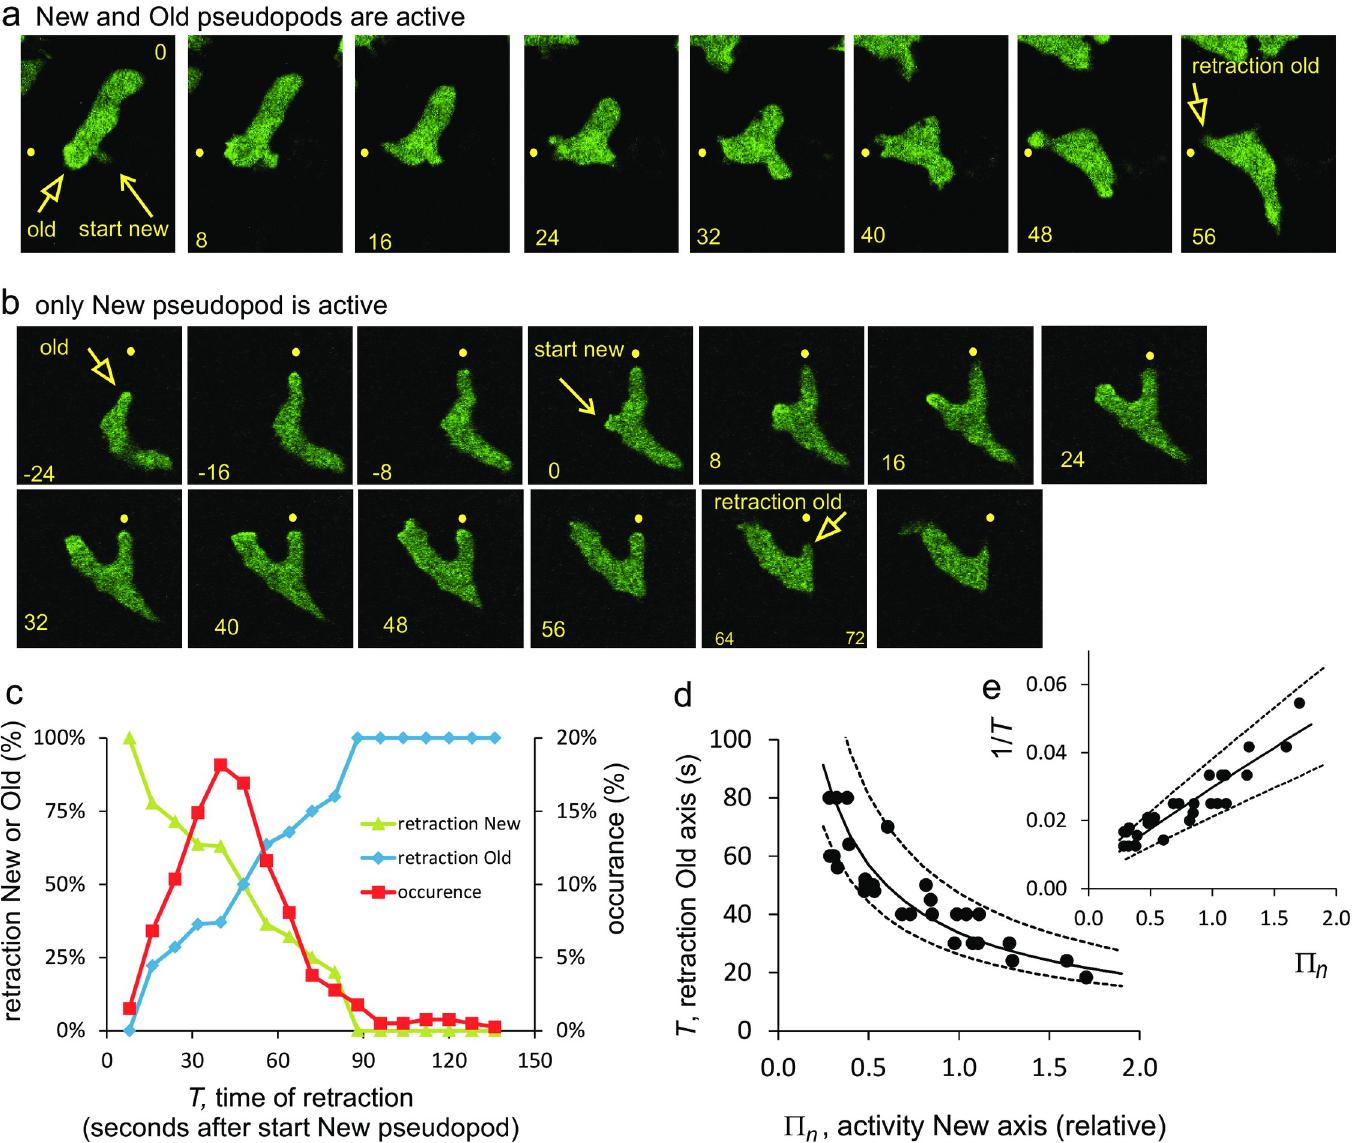
Fig 7. Kinetics of memory of polarity axis. Wild-type AX3 cells expressing Raf-RBD-GFP are moving in buffer. At t = 0 seconds the cells extend a de novo pseudopod, generating a NEW front. Pseudopod activity (seize and frequency) was measured in the New and Old front, as well as the time of retraction (T) of the pseudopod in the Old or the New front. Panels a show an example in which both the Old and New front exhibit pseudopod activity. Panels b show an example in which only the New front exhibits pseudopod activity. c. All 98 cases of a de novo pseudopod were analyzed for the retraction of either the Old or the New front. d. Detailed analysis of the subset of 28 cases in which only the New front exhibits pseudopod activity and the pseudopod in the Old front is retracted at time T. The experimental data were fitted to Eq (7) yielding a half-time of learning (25.7 ± 4.6 s) and forgetting (88 ± 43) of the polarity axis (optimal fit and 95% CI). The full line is the optimal fit, the dashed lines give the 95% confidence